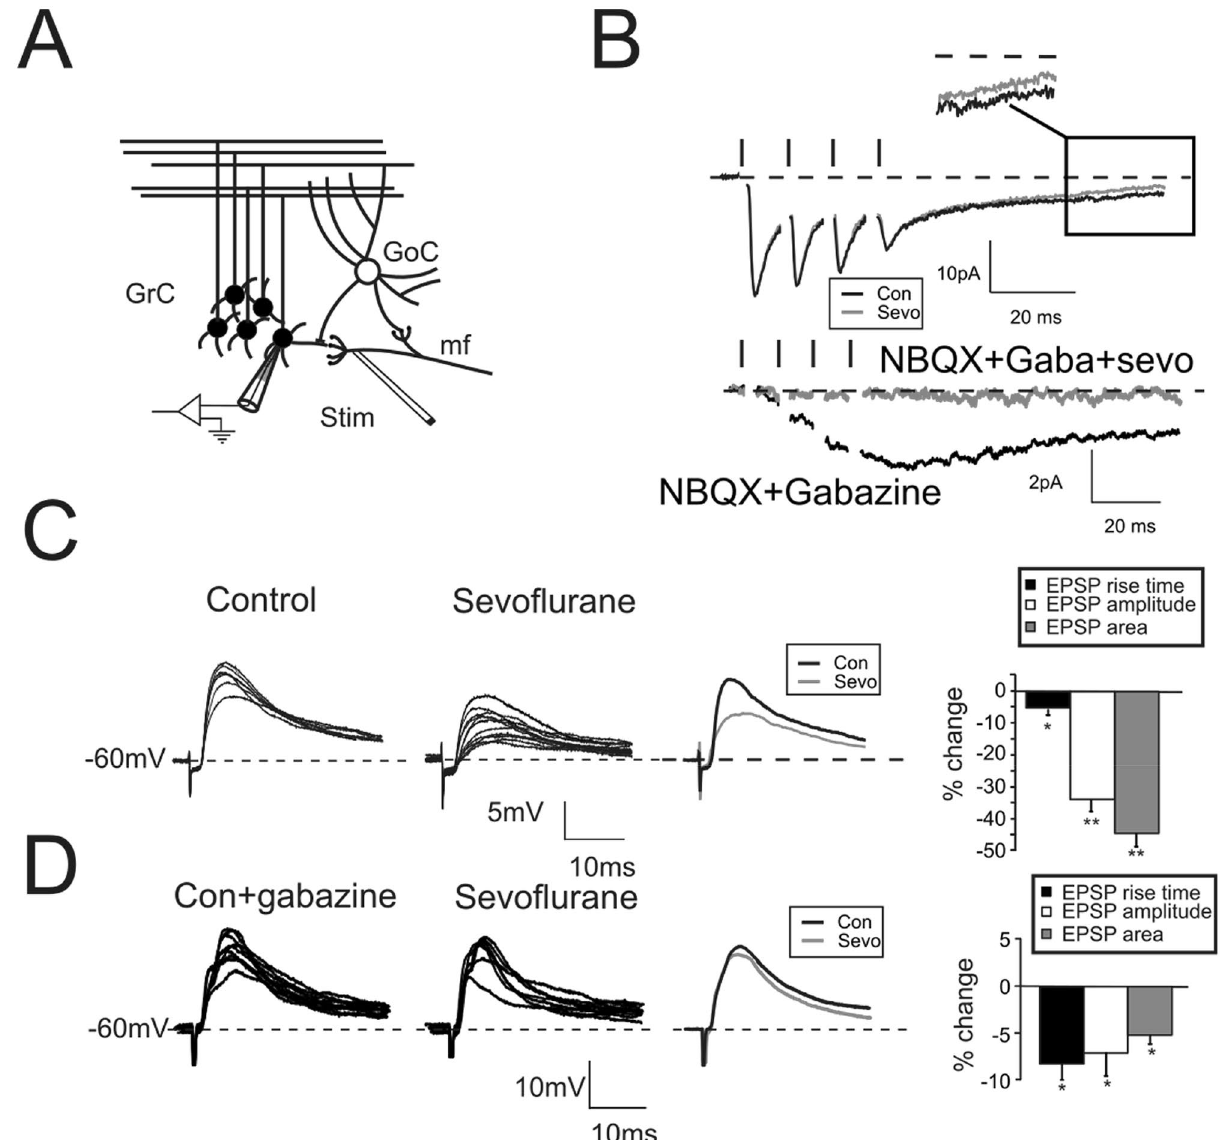
Figure 1. Modulation of excitatory neurotransmission by sevoflurane. ( A ) Scheme of the granular layer microcircuit. The stimulating electrode (stim) is positioned onto the mossy fiber bundle (mf) in order to activate excitatory synapses. GoC, Golgi cell (local interneuron); GrC, granule cell (output cell). ( B ) Top, EPSCs elicited in response to 4 pulses at 100 Hz and recorded from a GrC voltage clamped at − 70 mV (n = 9). Note the effects on the residual current induced by sevoflurane (gray trace, box). Bottom. In a different cell EPSCs were evoked from a GrCs voltage clamped at − 40 mV and in the presence of gabazine and NBQX (n = 8). Sevoflurane completely abolished the NMDA current. ( C ) EPSPs elicited by sub-threshold stimuli in GrCs at – 60 mV (10 superimposed traces) in control conditions (left) and in the presence of sevoflurane (middle). The average traces (right) show the marked decrease of EPSP amplitude and area induced by sevoflurane (gray trace). Histogram summarizes the effects induced by sevoflurane on EPSP rise time, amplitude, and area (n = 7). In this and in the following figures: * p < 0.05; ** p < 0.01. ( D ) EPSPs were recorded from GrCs at – 60 mV (10 superimposed traces) and in the presence of gabazine (top traces) to unmask the NMDA component (n = 4) in control (left) and in the presence of sevoflurane (middle). The average traces (right) show that sevoflurane decreases both peak amplitude and EPSP area. Histogram summarizes the effects induced by sevoflurane on EPSP rise time, amplitude, and